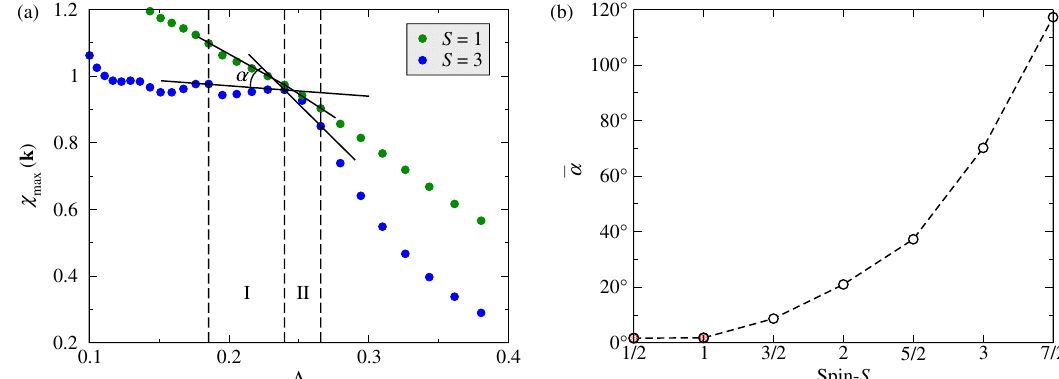
FIG. 25. (a) Illustration of the scheme for determining kinks in the Λ -dependent susceptibility flow: One divides a fixed Λ interval into two regions, I and II, which by construction lie between two adjacent pairs of susceptibility kinks or peaks. Within each region, χ ð k Þ is approximated by a tangent connecting the neighboring kinks. We find that, while the angle between the two tangents is negligible for S ¼ 1 , it acquires a sizable finite value for S ¼ 3 , implying that two curves represent different phases. To obtain a more quantitatively robust measure for the size of the kink, we consider additional pairs of adjacent peaks, compute the angles between their tangents, and calculate the average angle ¯ α . (b) Averaged angle ¯ α as a function of spin S . While ¯ α is negligible and almost constant for S ¼ 1 = 2 and S ¼ 1 (labeled by filled circles), there is a pronounced increase for higher values of spin S ≥ 3 = 2 (empty circles). Based on this behavior, we estimate the phase transition of the spin- S nearest-neighbor Heisenberg antiferromagnet to occur for S ¼ 3 = 2